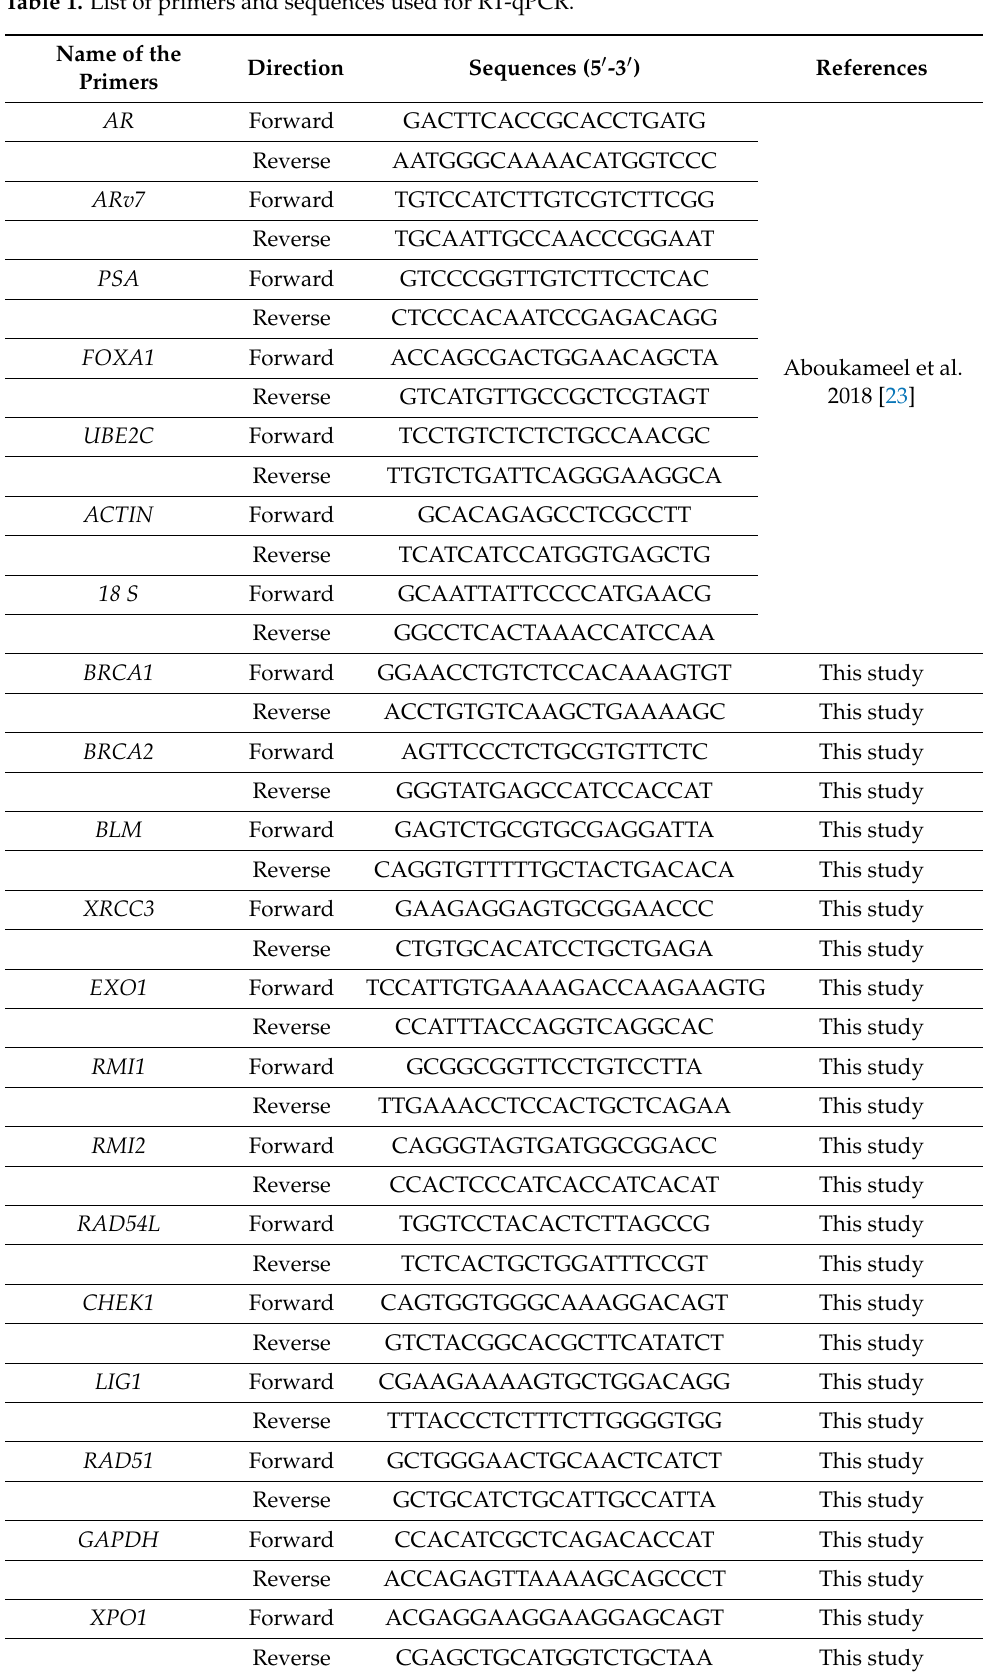
Table 1. List of primers and sequences used for